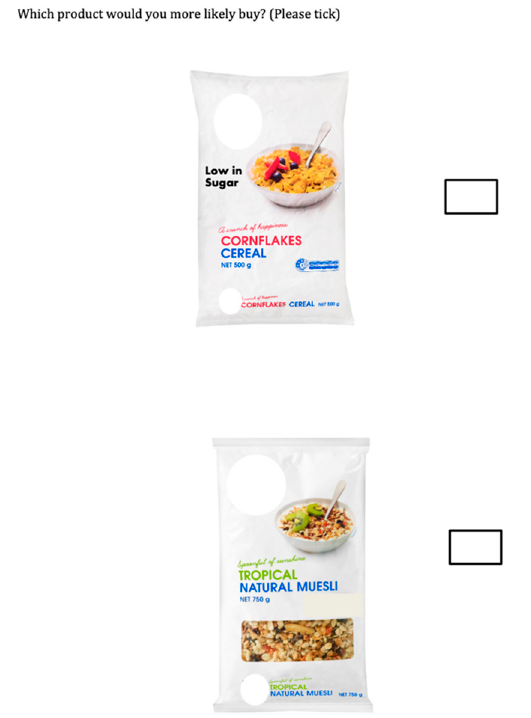
Figure A3. Focus group stimulus activities.